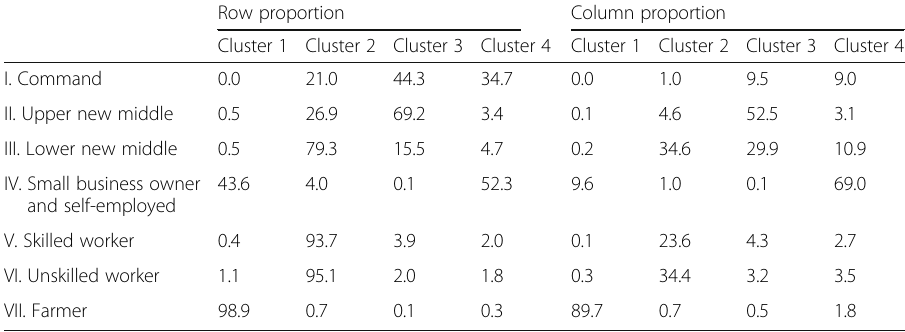
Table 4 Estimated two-way margins of 4 cluster LCA models by Xin Liu ’ s class scheme: 2010 CGSS Row proportion Column